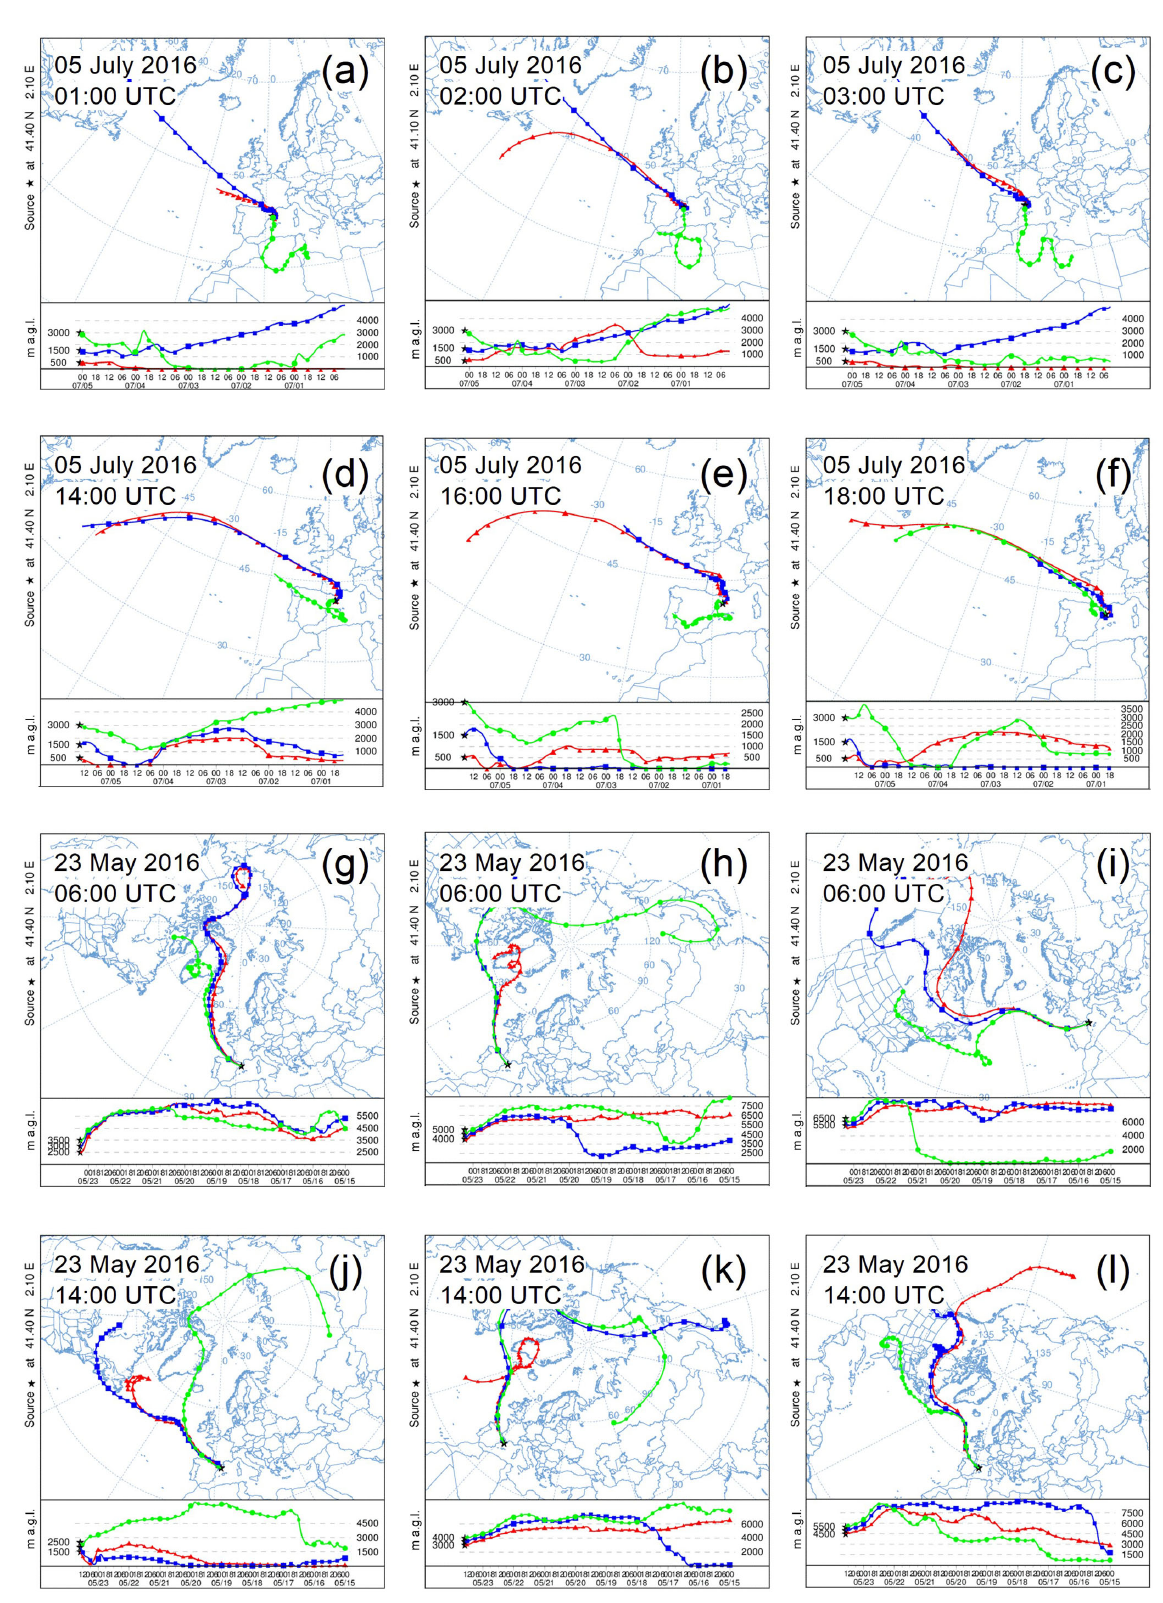
Figure 1. HYSPLIT back trajectories ending at different altitudes over BCN depending on the aerosol case (only for the dust and smoke cases): (a) – (f) for dust (5 days back) on 5 July 2016 and (g) – (l) for smoke (10 days back) on 23 May 2016. Selected times of the air mass arrivals are related to those aerosol profiles that are examined in particular (as shown in Sect. 3; in particular, see Figs. 4 and